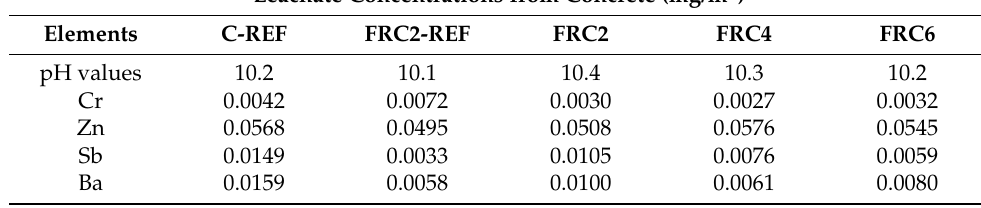
Table 3. Leachate concentrations (mg/m 2 ) from concrete specimens according to the diffusion leaching